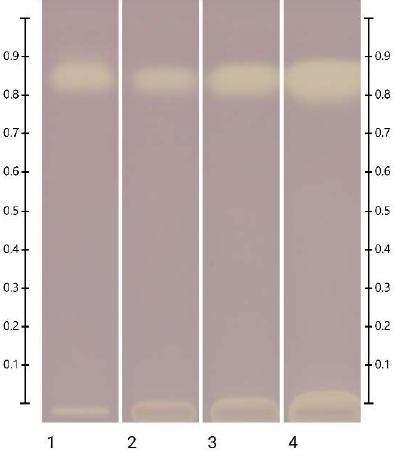
Figure 7. Images of HPTLC plate taken under white light 60 min after derivatisation with DPPH* reagent; Track 1— ART short-term storage at 60 °C for 5 months (5 μL), Track 2—HMF (20 mg/mL) aqueous solution (3 μL), Track 3—HMF (20 mg/mL) aqueous solution (5 μL), and Track 4—HMF (20 mg/mL) aqueous solution (10 μL). 2.3. Analysis of HPTLC-DPPH Activities of the Organic Extracts of the Honeys Changes in antioxidant activity on exposure to different temperatures over time, re- flected in the respective HPTLC-DPPH fingerprints, were recorded for all three honeys (LEP, MAR, PEP), as well as the artificial honey (ART). The samples were analysed under white light 1 h after derivatisation with DPPH* reagent, with any bands exhibiting anti- oxidant activity reacting with the reagent, thus showing a change from its inherent purple colour to yellow. The formation of any yellow bands is thus indicative of antioxidant ac- tivity, and the intensity of the yellow colour correlates with the intensity of the effect [48,50]. Major changes seen in the four samples on exposure to the four temperature con- ditions over five months are described below. The honey samples stored at ambient temperature (approximately 25 °C) did not show any changes in their respective HPTLC-DPPH fingerprints (data not presented). When stored at 40 °C, 60 °C and 80 °C, the antioxidant band activities of the honeys changed over time, and for the samples stored at 80 °C, it was impossible to record any data beyond 48 h exposure due to the caramelisation of the samples. As expected, there were no visible changes in the HPTLC-DPPH fingerprints of the ART honey at 40 °C, 60 °C and 80 °C during the short-term study (Supplementary Figures S52 and S53). Storage at 40 °C for up to 5 months also did not result in the formation of any antioxidant bands (Supplementary Figures S54a and S55). However, a faint band with antioxidant activity started to appear at Rf 0.32 after two months in the sample kept at 60 °C (Figure 8 and Supplementary Figure S56). Interestingly, the Rf value of this band cor- responds to that of the heat-induced artefact detected by HPTLC that emerged in the ART and all the other honeys over time, particularly on exposure to higher temperatures.